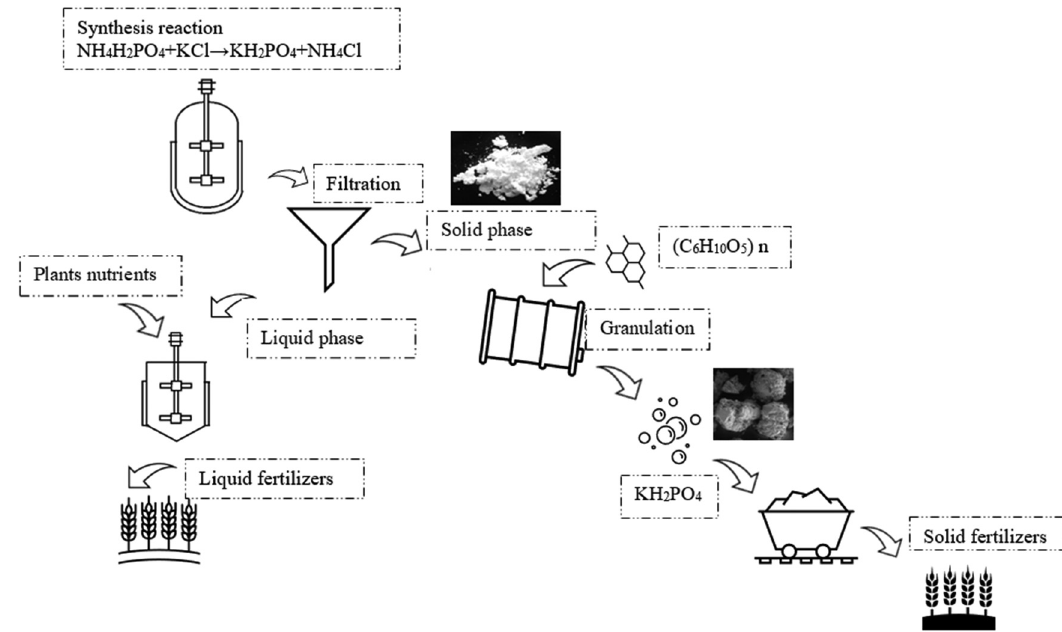
Figure 1: PDP synthesis and obtaining fi nal granulated